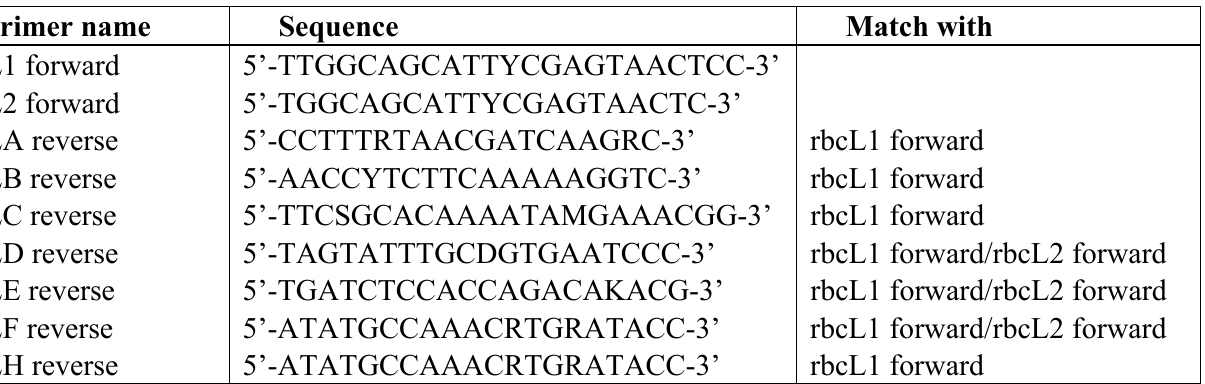
Table 2. Sequences and matching of rbcL